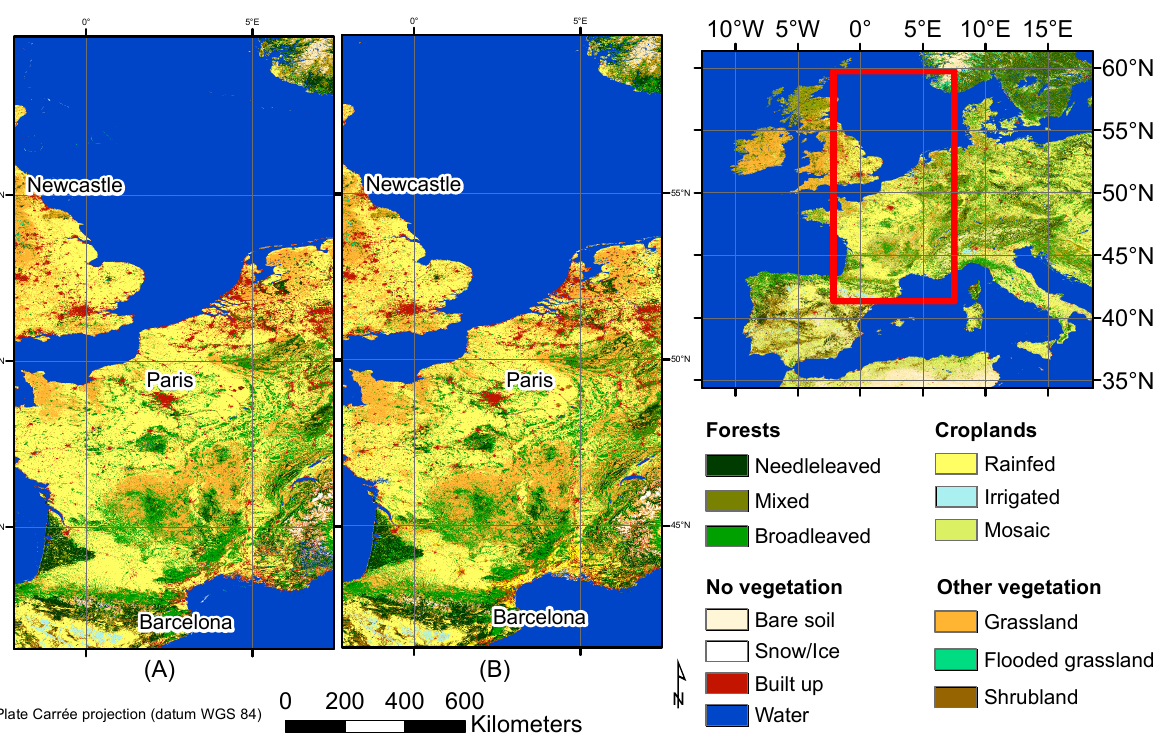
Figure 4. Classification results with ( A ) SVM and ( B ) Gaussian maximum likelihood in Western Europe. The Globcover 2009 product is provided for comparison on the